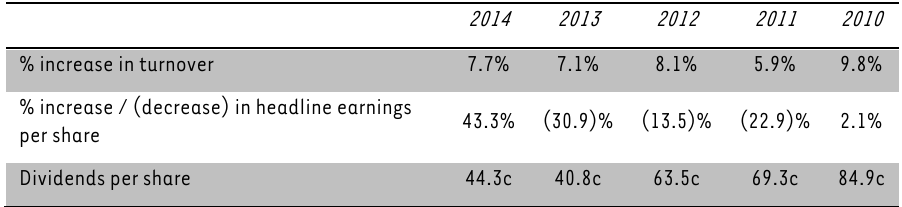
TABLE 7: Pick n Pay performance statistics from 2010 to 2014